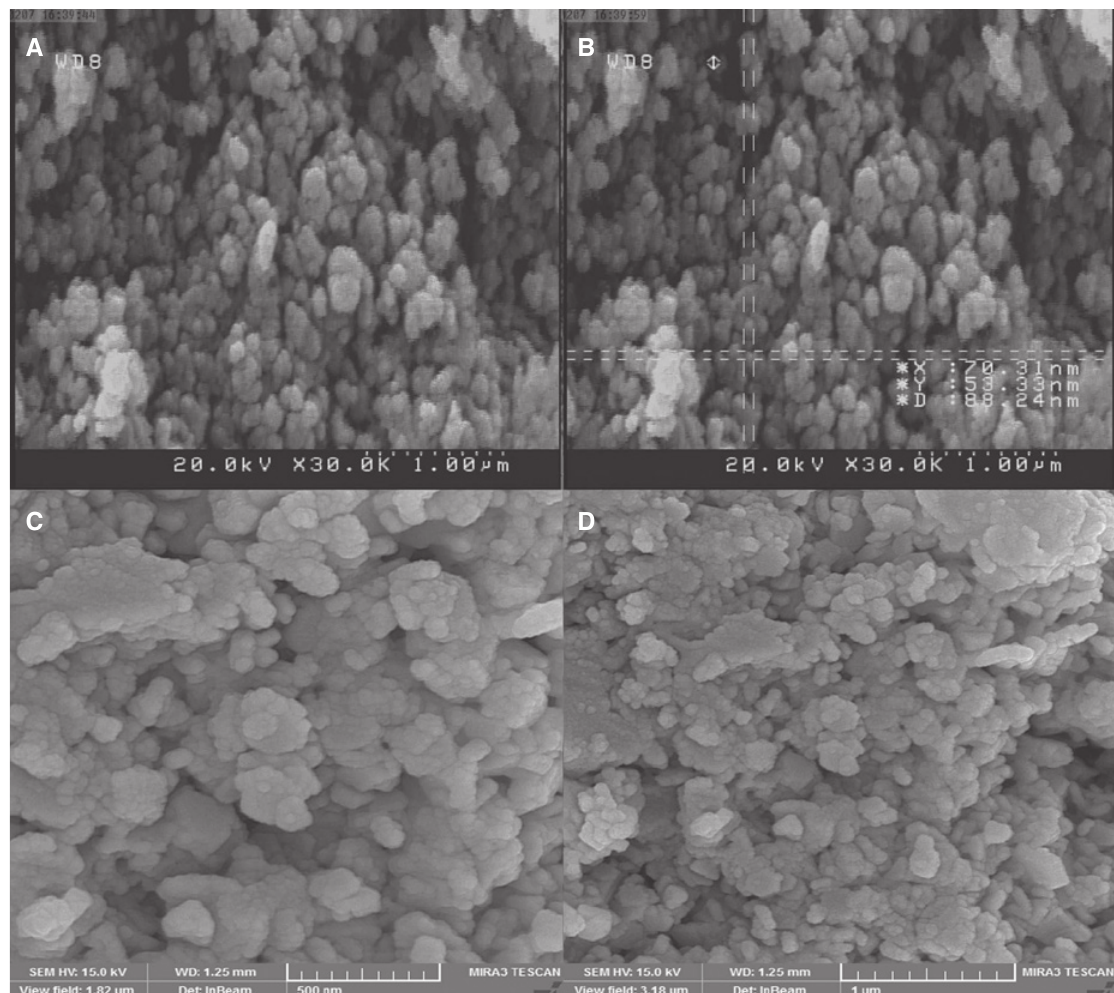
O at (A, B) 500 ° C and (C, D) 850 ° C. 12 19